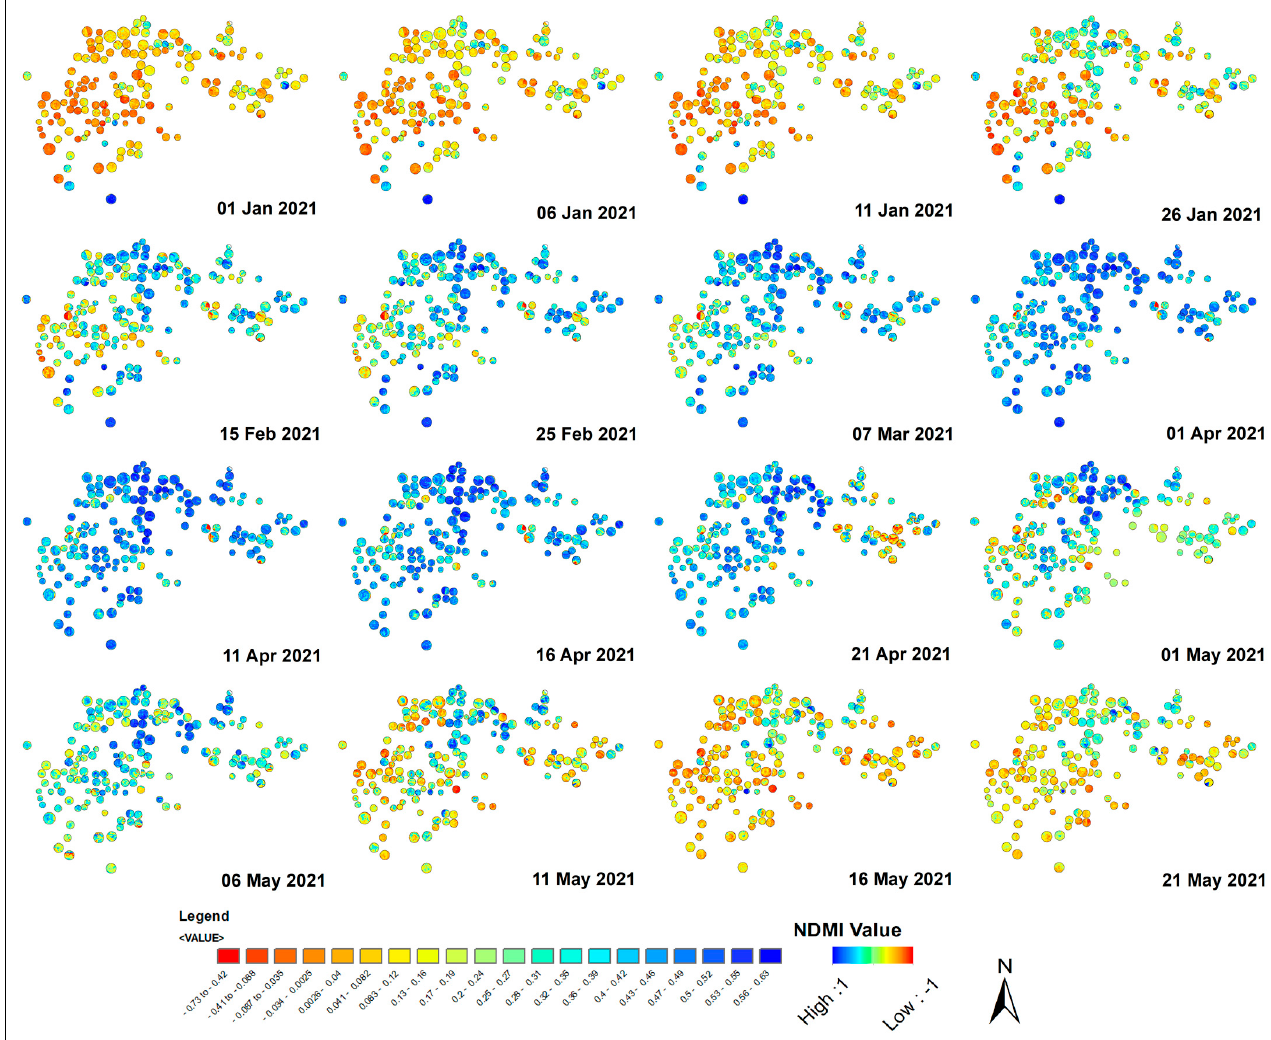
Figure 8. Temporal Variation in the NDMI Value of Center pivot fi elds in 2021.